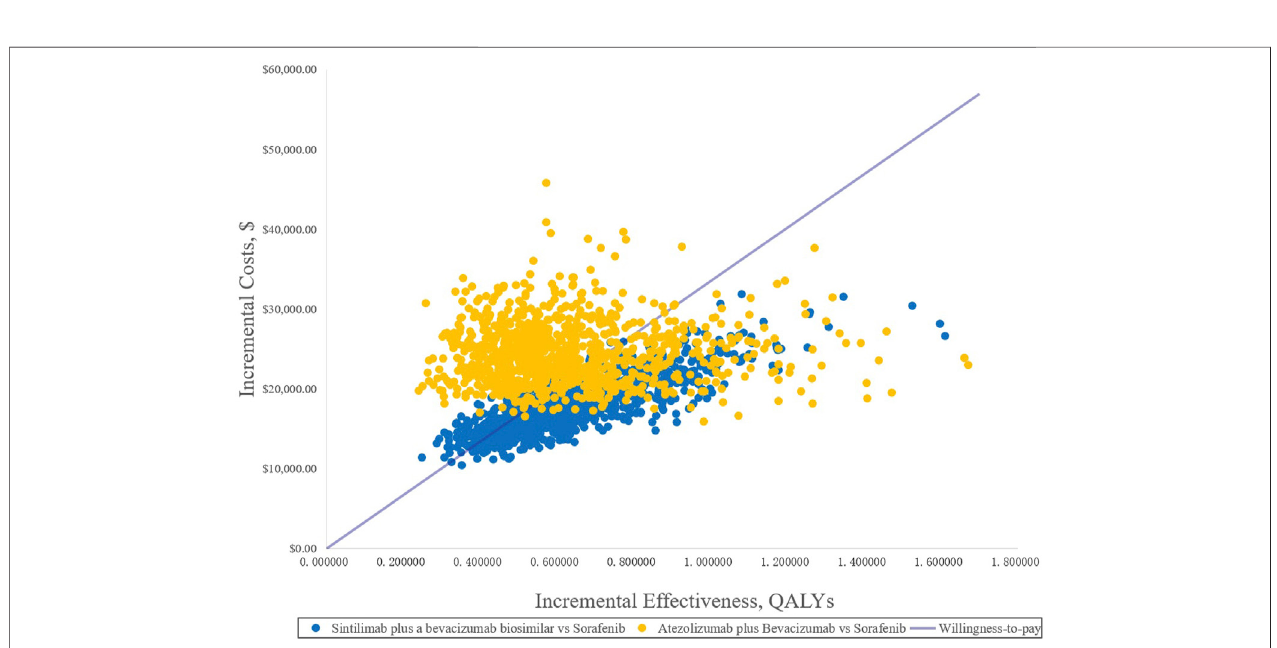
FIGURE 7 | Incremental cost-effectiveness scatterplots of the scenario analysis. QALYs, quality-adjusted life years.